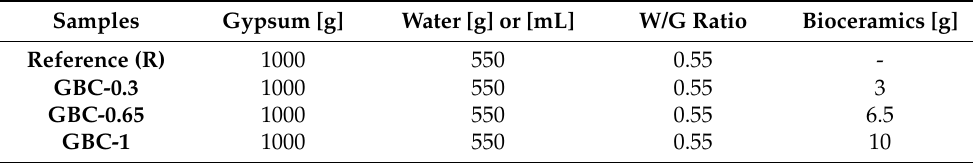
Table 3. Gypsum plasters composition (per kilogram of powder